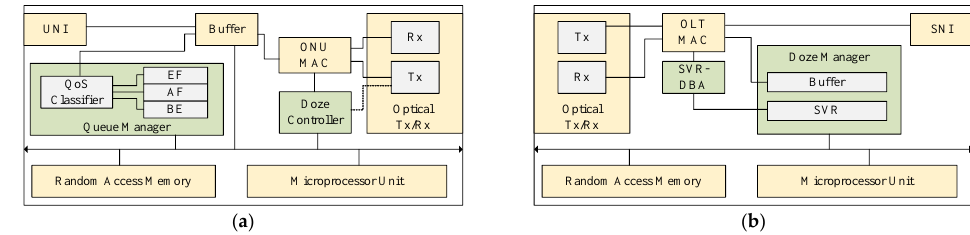
Figure 1. The proposed architecture for ( a ) ONU and ( b )